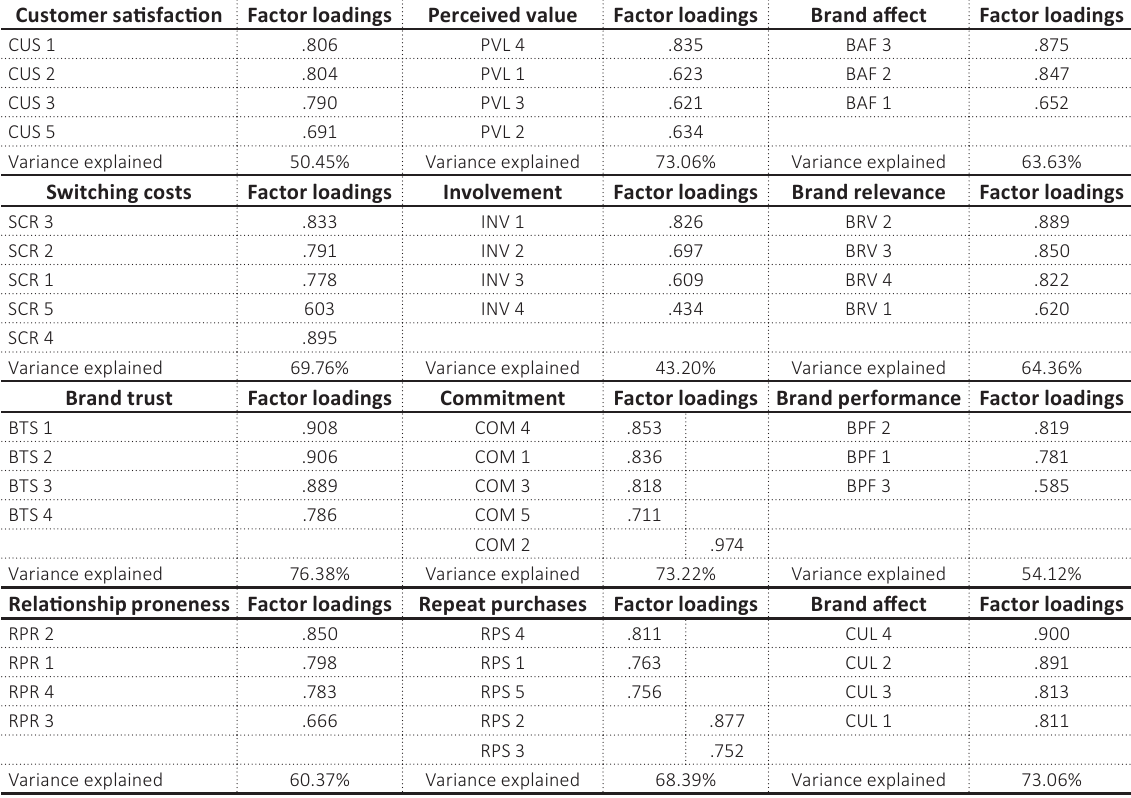
Table 3. Validity results of factor analysis on individual loyalty antecedents Customer satisfaction Factor